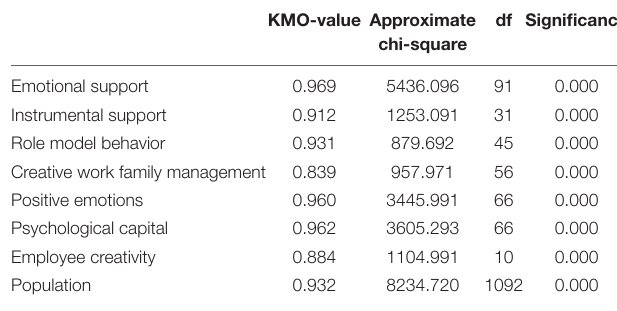
TABLE 3 | Validity result